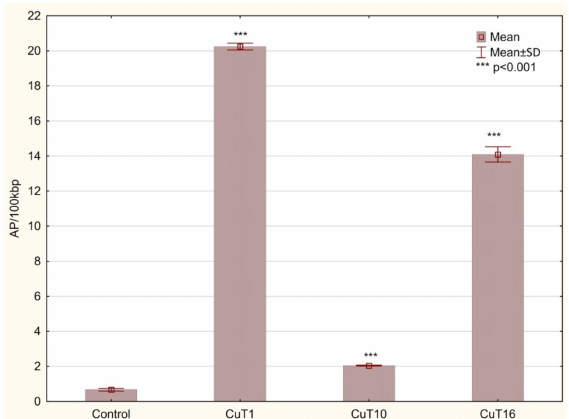
Figure 9. The amount of AP sites/100 kbp in DNA of A375 cells treated for 24 h with CuT1, CuT10, and CuT16 compound in concentration corresponding to appropriate IC50 value (69.92, 26.05, and 144.60 µ M, respectively) or DMSO as vehicle in control cultures. Data presented as mean ± SD derived from three independent experiments.